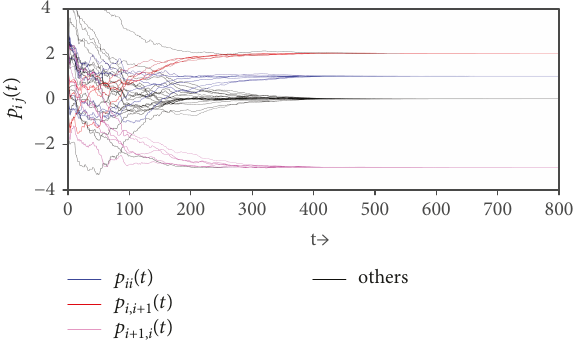
Figure 6: The convergence of the topology updating laws p t in ij − c the adaptive controllers (15): lim . p t = c t → ∞ ij ij ij In particular, the blue lines indicate that lim p t = 1 , t → ∞ ii the red lines indicate that lim p t = 2 , the magenta t → ∞ i , i +1 lines indicate that lim p t = − 3 , and the black lines t → ∞ i +1 , i indicate that lim p t = 2 , lim p t = − 3 , and t → ∞ t → ∞ 61 16 lim p t = 0 for other elements. Therefore, the second t → ∞ ij item of Theorem 1 is veri fi ed by Figures 5 and 6.